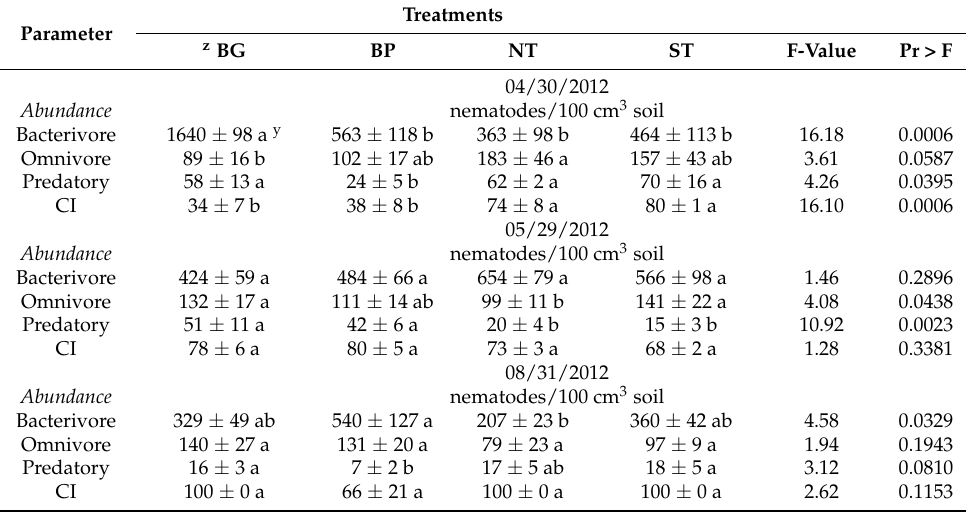
Table 3. The effect of plasticulture and tillage treatments on abundance of bacterivorous, omnivorous and predatory nematodes at 2 weeks before cover crop termination (4/30), mid (5/29) and end (8/31) of eggplant crop in